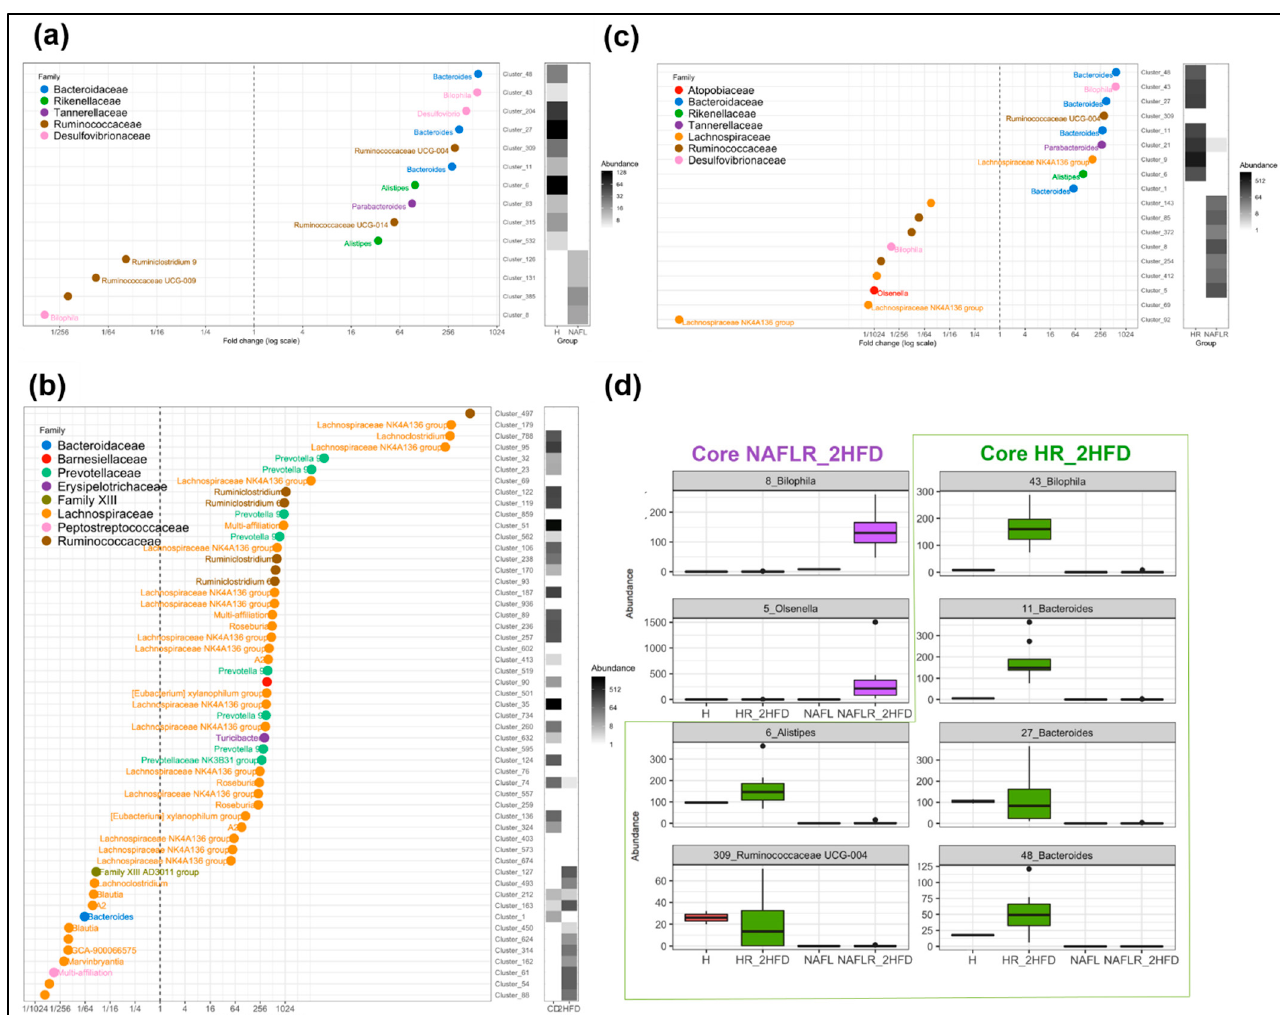
Figure 11. Graphical representation of differentially abundant OTUs, having a large fold change and significant effect size in addition to high relative abundance between ( a ) healthy, H, and NAFL inocula ; ( b ) HR_CD and HR_2HFD groups on day 90; ( c ) HR_2HFD and NAFLR_2HFD groups on day 90. Each OTU is represented by a dot and colored according to its taxonomic classification at the family level. Taxonomy at the genus or species level is also indicated, when available, next to each OTU. A logarithmic scale (log-2) was used for the x axis. ( d ) Core NAFLR_2HFD and Core HR_2HFD abundance through the groups, corresponding, respectively, to the OTUs differentially abundant and transferred from inocula to mice. HR, healthy human microbiota receiver mice on 2HFD; NAFLR, NAFL patient microbiota receiver mice on 2HFD; 2HFD, high-fructose, high-fat diet.